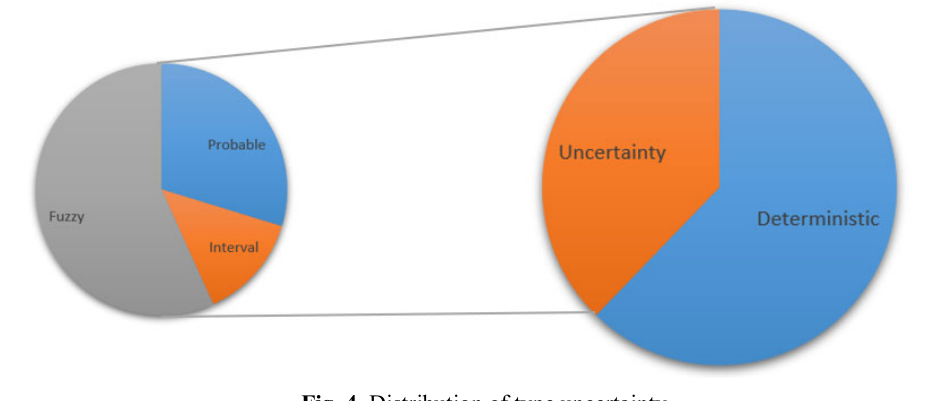
Fig. 4. Distribution of type uncertainty